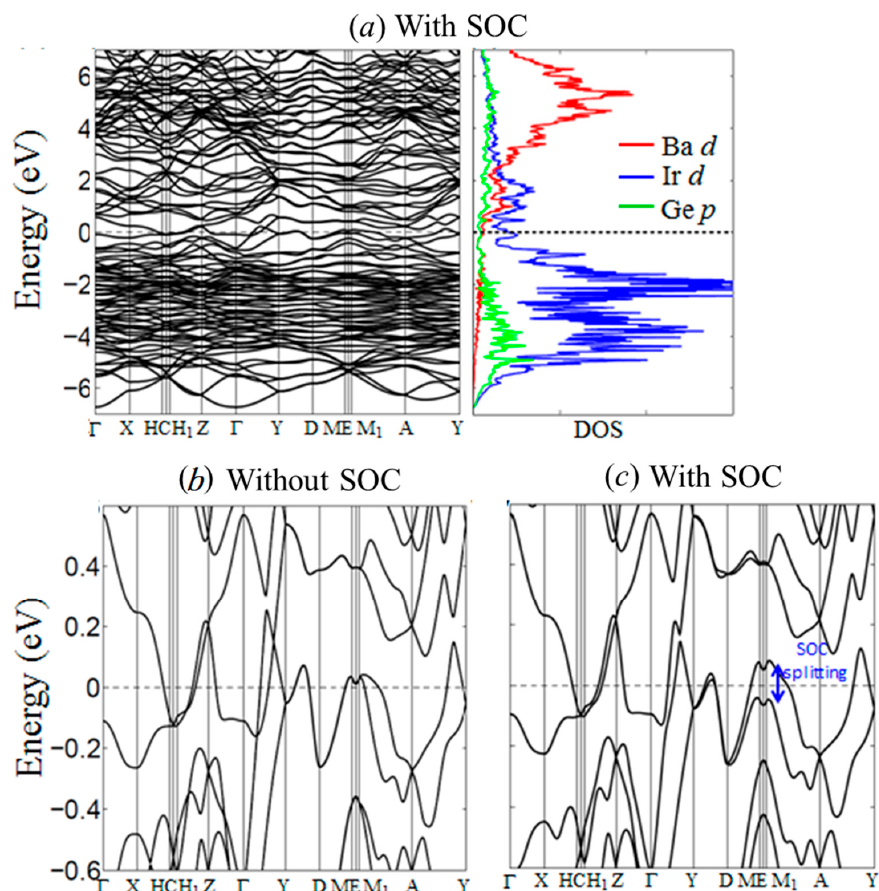
Figure 5. Calculated electronic band structure and density of states (DOS) of BaIr 2 Ge 2 using generalized gradient approximation (GGA). ( a ) Band structure and DOS with spin-orbit coupling emphasis on the energy range from − 7 to +7 eV; ( b ) Band structure calculated by GGA without spin-orbit coupling; ( c ) Band structure calculated by GGA with spin-orbit coupling.